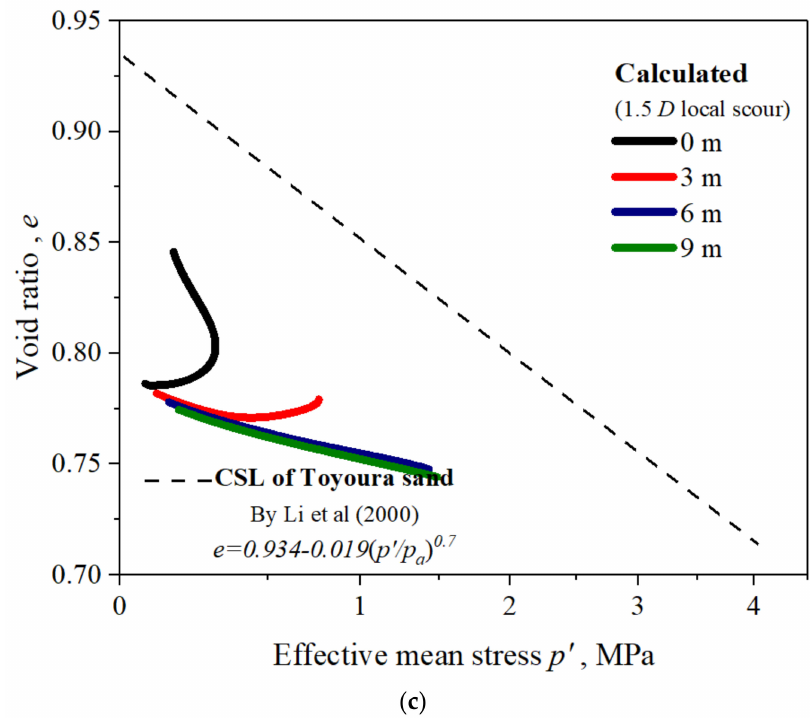
Figure 8. Modified data and theoretical fitting of the CSL (critical state line) in e-p’ space for Toyoura sand in ( a ) no scour condition; ( b ) general scour condition; ( c ) local scour